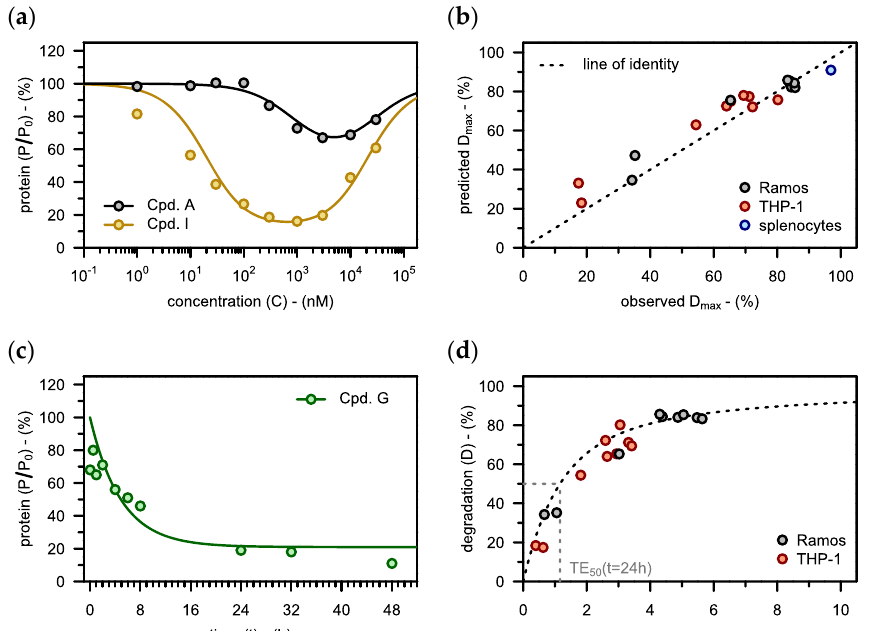
Figure 4. ( a ) The rate constant of PROTAC-catalyzed protein degradation is fitted to the concentration-degradation profile observed for the lead compound ( Cpd. A ) in Ramos cells ( 𝑘 cat = 4.6 h −1 ). This is the only parameter in this figure that was derived by model fitting. Subsequently, the model is used to predict, what binding affinities would give the orange profile. The optimized compound ( Cpd. I ), which features the binding affinities suggested by the model (see Table S1), exhibits the desired concentration-degradation profile. ( b ) Based on the 𝑘 cat value from Cpd. A and the biochemical input data (Tables S1 and S2), the maximal extent of degradation ( 𝐷 max ) is predicted for different compounds in different cell types. These predictions are plotted against the estimates for 𝐷 max obtained by characterizing the respective experimental concentration-degradation profiles with the hook model (see Figure 3b). There is good agreement between the predicted and the observed values, as indicated by Pearson’s correlation coefficient ( 𝜌 = 0.97 ). ( c ) The time-course of degradation in Ramos cells following incubation with Cpd. G ( 𝐶 = 100 nM ) is predicted using the 𝑘 cat value from Cpd. A . ( d ) The maximal extent of degradation ( 𝐷 max ) observed for the nine compounds from before is plotted against the respective target engagement ( 𝑇𝐸 ) values calculated using Equation (3). Equation (15) predicts a hyperbolic relationship ( 𝑇𝐸 50 ≈ 1% ). Experimental data ( a – d ) taken from Zorba et al. [21].